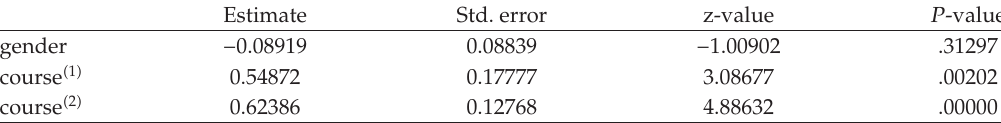
Table 5: Estimates of constant e ff ects.